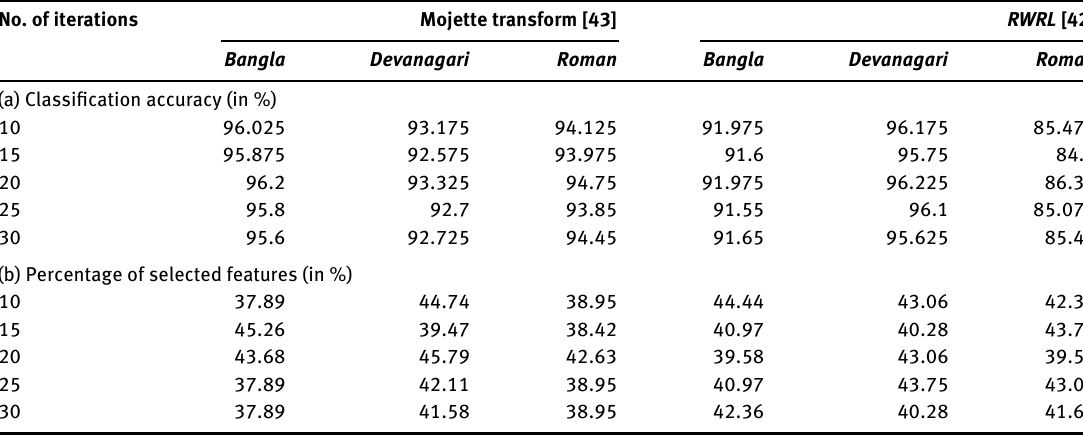
Table 3: Effect of Change in Number of Iterations with (a) Classification Accuracy of Selected Features and (b) Percentage of Features Selected in